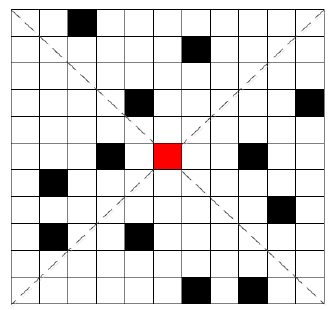
Figure 5. Inverse distance weighted ( IDW) algorithm. Black boxes represent ground points, and red boxes represent points to be interpolated.